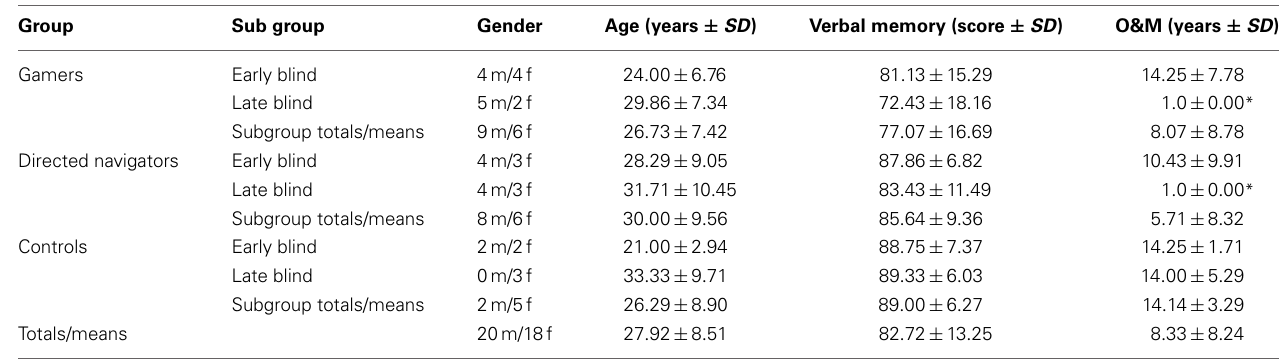
Table 1 | Participant characteristics separated by study